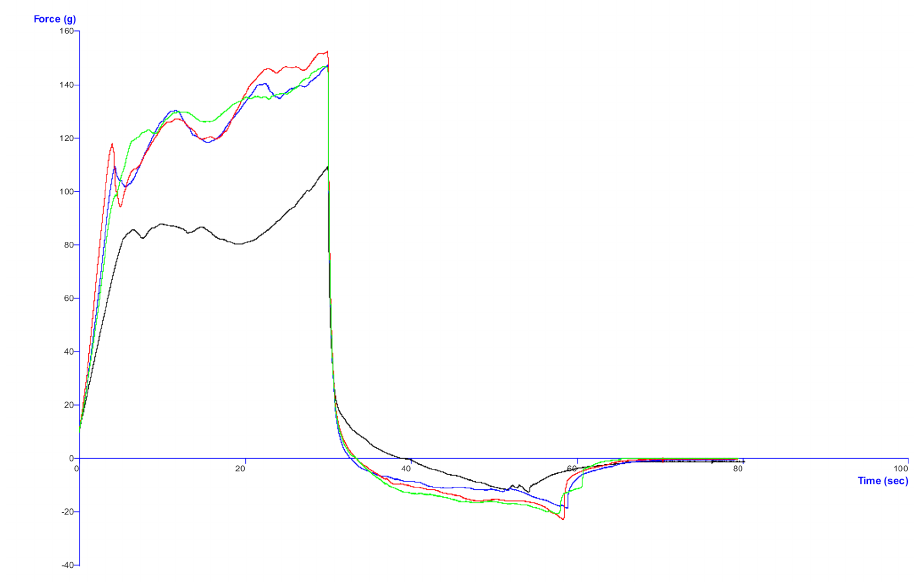
Figure 3. Analysis of the texture profile of kefir samples on the twentieth day of